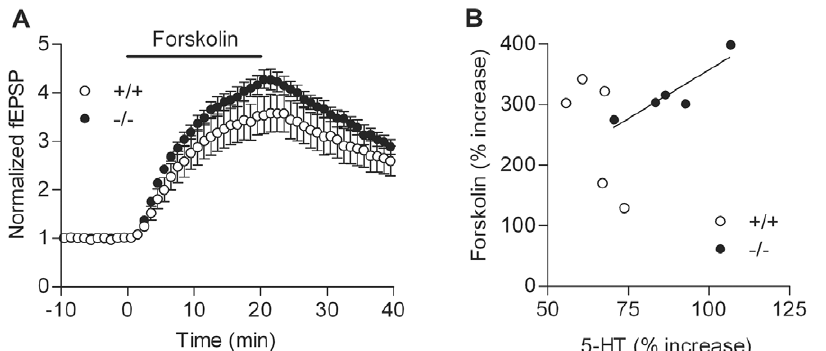
Figure 4. Synaptic potentiation induced by forskolin at mossy fiber synapse. (A) Pooled data showing potentiation of mossy fiber synaptic transmission by bath-applied forskolin (10 m M). There was no significant difference in the magnitude of potentiation between wild-type and mutant mice ( p =0.6905, n=5 each). The effect of serotonin examined in the same mice was shown in (B) and was larger in mutant mice ( p =0.0159). (B) Significant correlation between serotonin- and forskolin-induced synaptic potentiation in mutant mice (r 2 =0.8177, p =0.00351), but not in wild-type mice (r 2 =0.5067, p =0.1775).